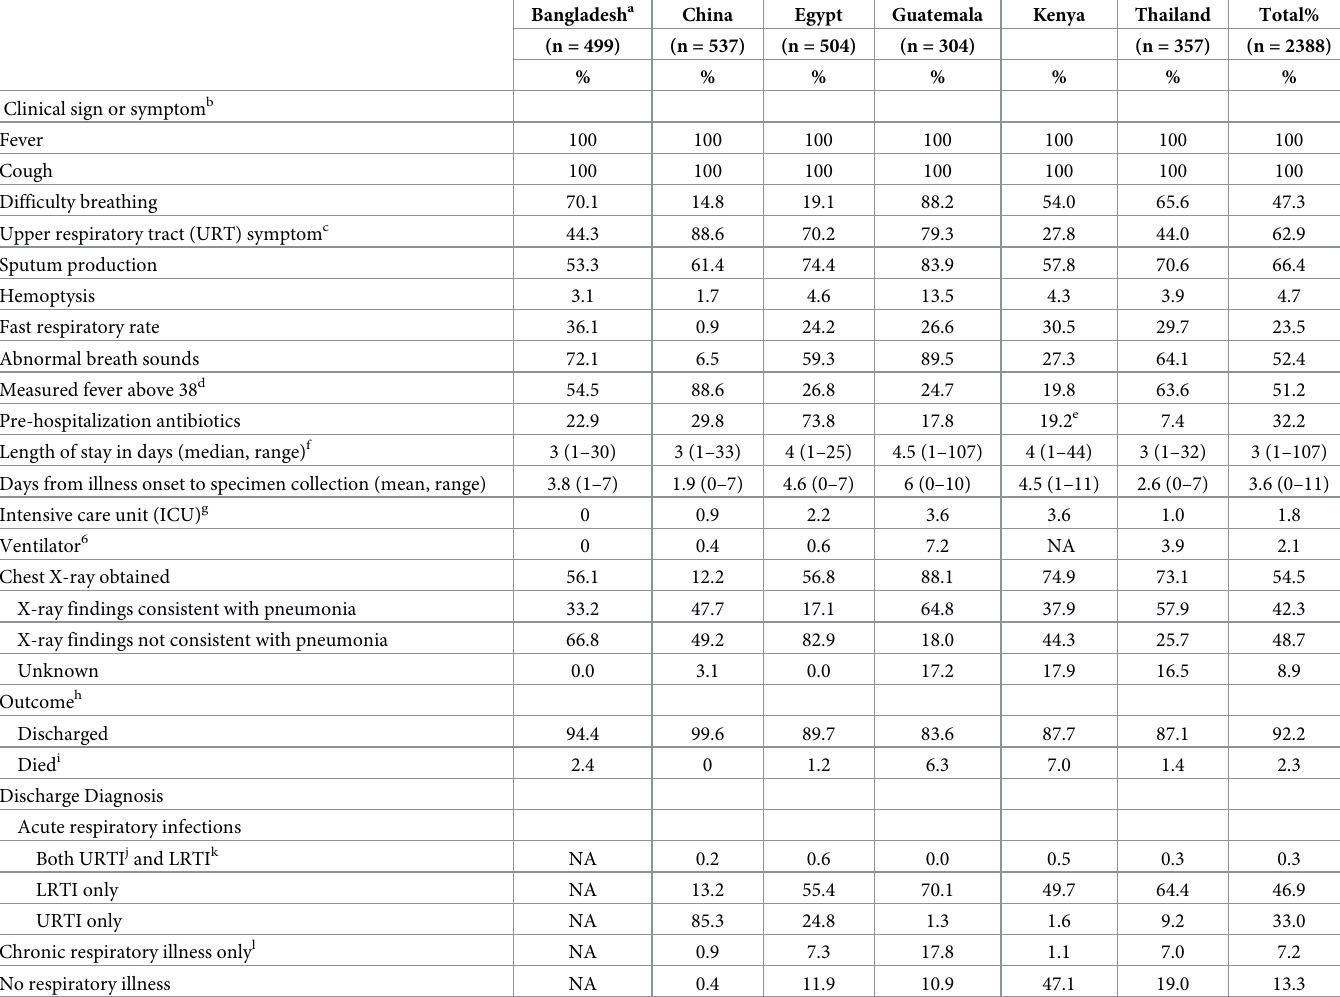
Table 3. Clinical description and hospital course of severe acute respiratory infection (SARI)